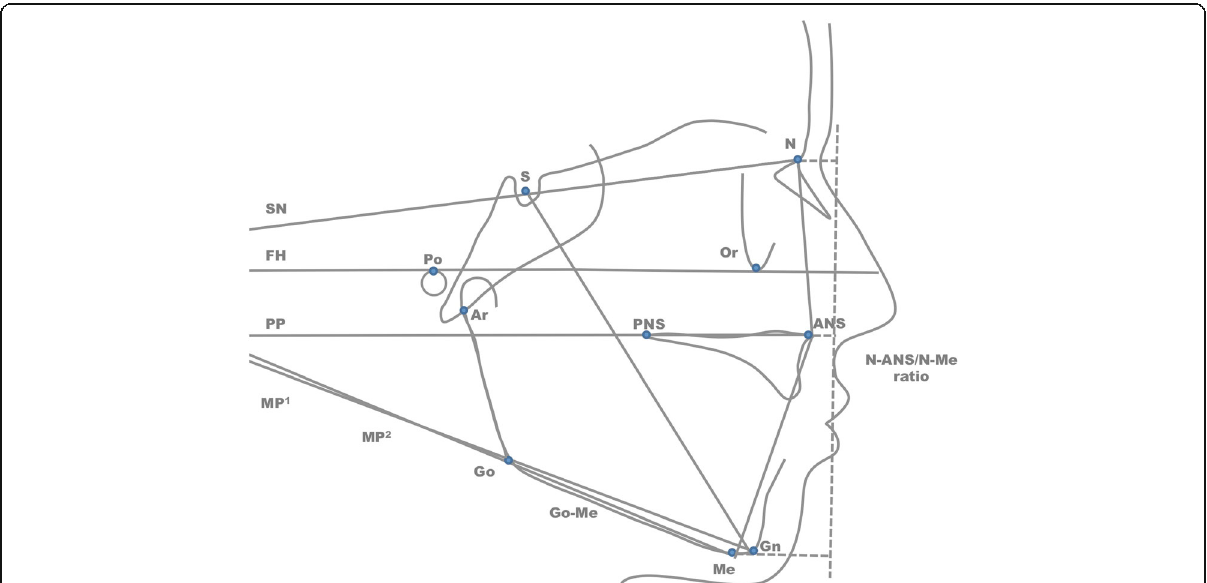
Fig. 2 Points, planes, and lines used in the cephalometric analysis. Points: sella (S), nasion (N), po (Porion), orbitale (O), articulare (Ar), anterior nasal spine (ANS), posterior nasal spine (PNS), gonion (Go), menton (Me), gnathion (Gn). Planes: sella-nasion (SN), Frankfurt horizontal (FH), palatal plane (PP), mandibular plane 1 (Go-Gn), mandibular plane 2 (Go-Me). Lines: sella to gnathion (S-Gn), dashed line perpendicular to